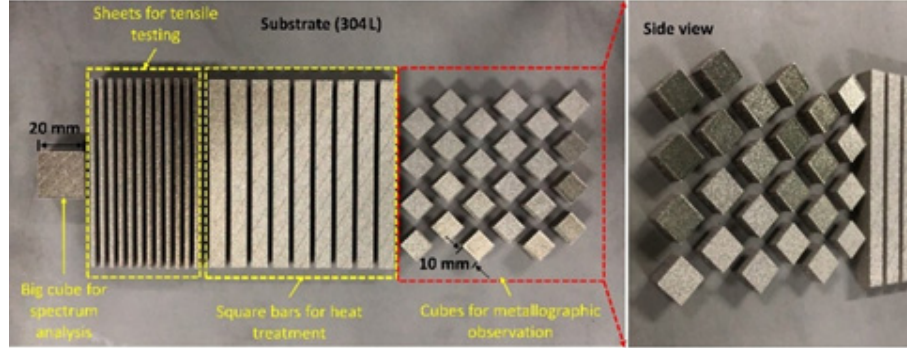
Figure 3. Optical image of as-printed samples via laser in situ alloying.